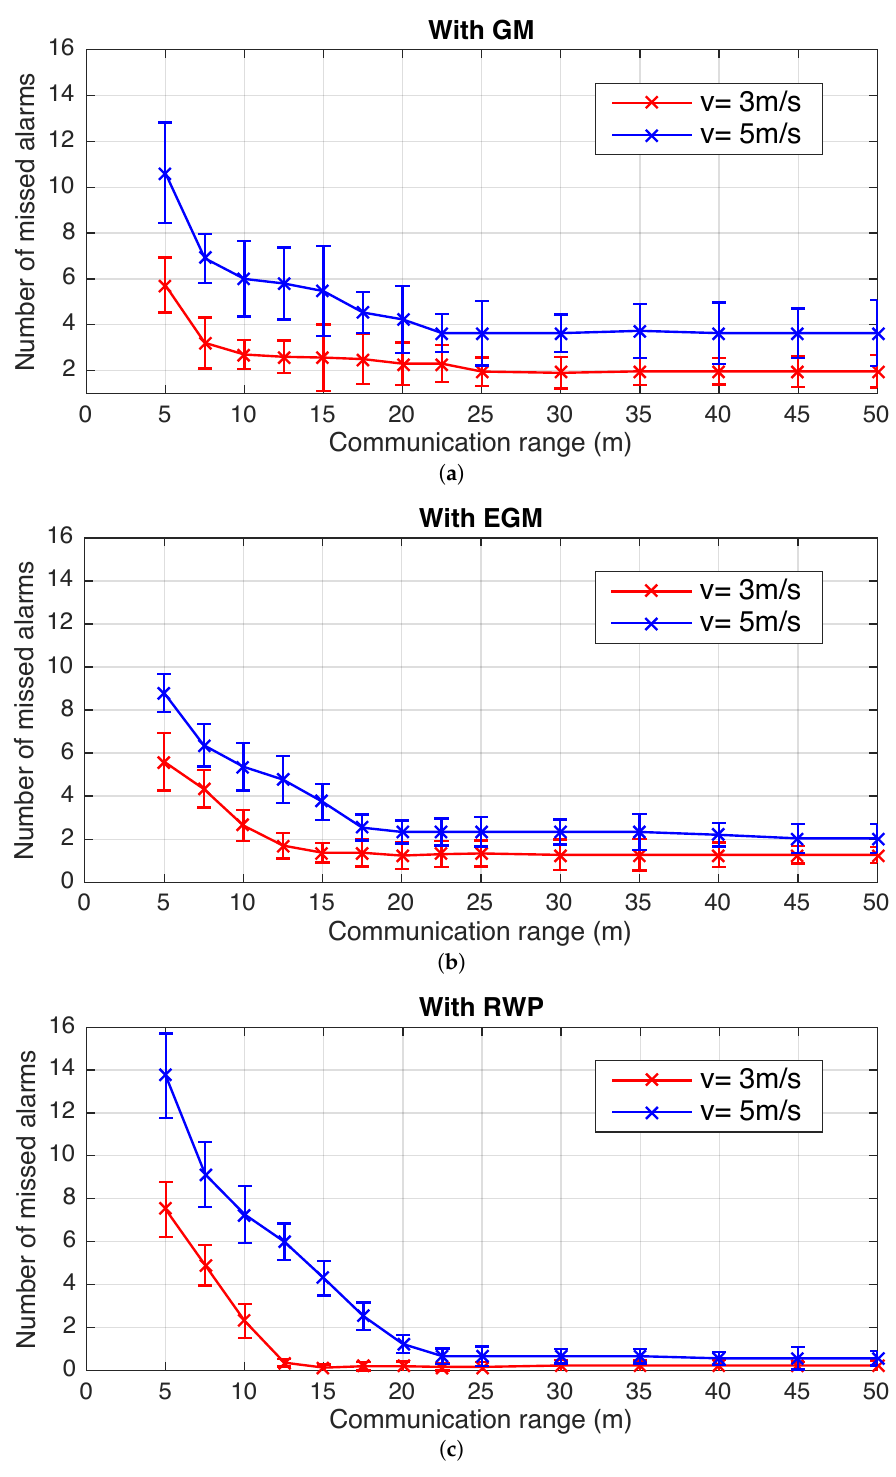
Figure 9. Average missed alarms under different σ using ( a ) GM; ( b ) EGM; ( c )